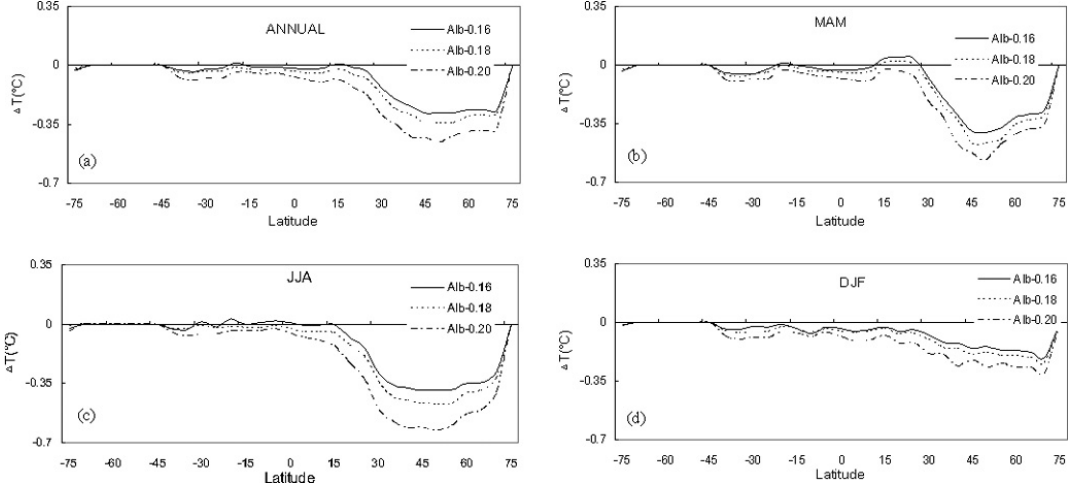
Fig. 4. Zonally averaged changes in temperature ( ◦ ) for different seasons, (a) annual; (b) MAM (March–May); (c) JJA (June–August); (d) DJF (December–February), for simulation ED.